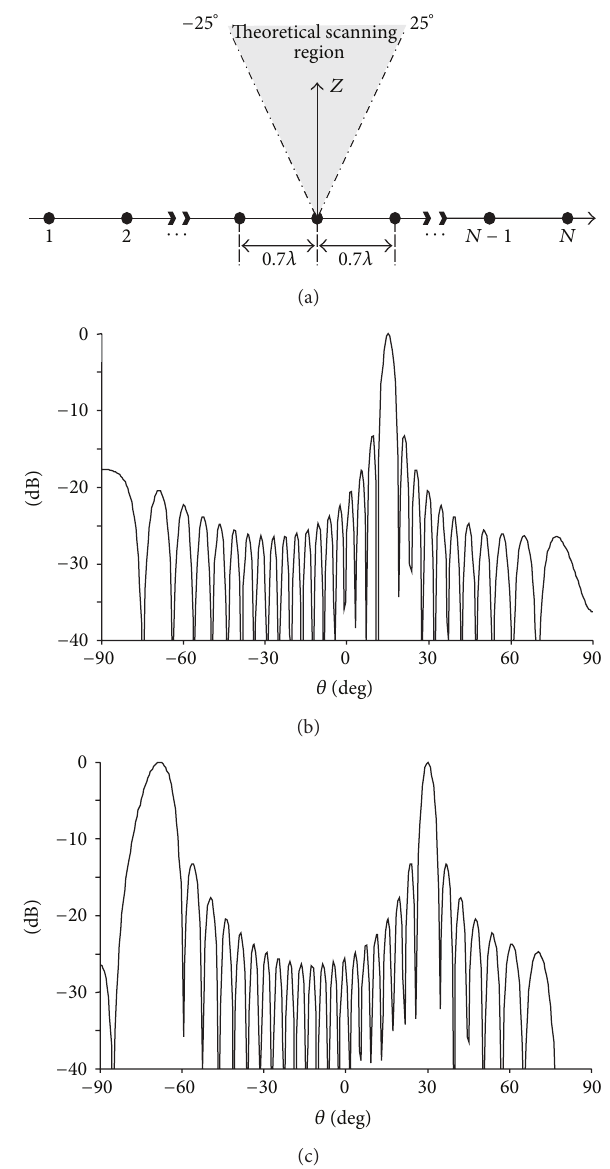
Figure 2: Scanning performances of an N -elements linear array with spacing equal to 0.7𝜆 : (a) allowable scanning area given by relation (1); (b) array factor for a scan angle 𝜃 𝑠 = 15 ∘ and 𝑁 = 21 ; (c) array factor for a scan angle 𝜃 𝑠 = 30 ∘ and 𝑁 = 21